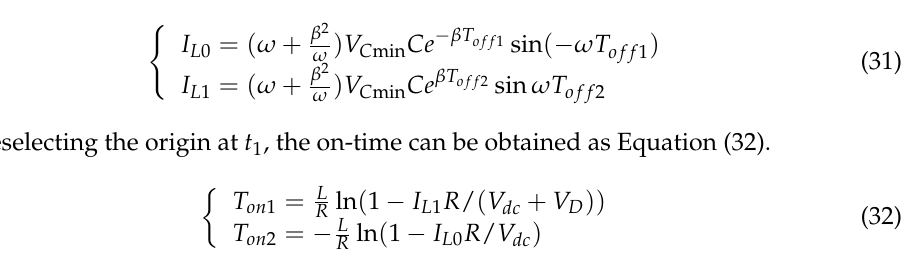
By combining (16) and (29), the off-times T off1 and T off2 can be solved by letting v C ( − T off 1 ) = v C ( T off 2 ) = V dc as Equation (30).